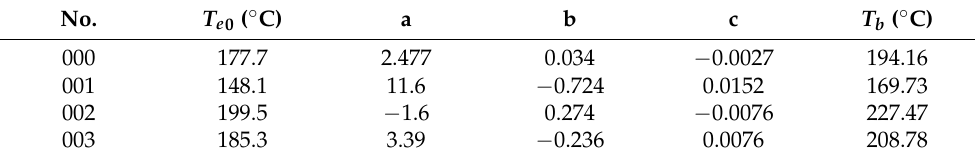
Table 5. The critical temperature of thermal explosion of emulsion explosives